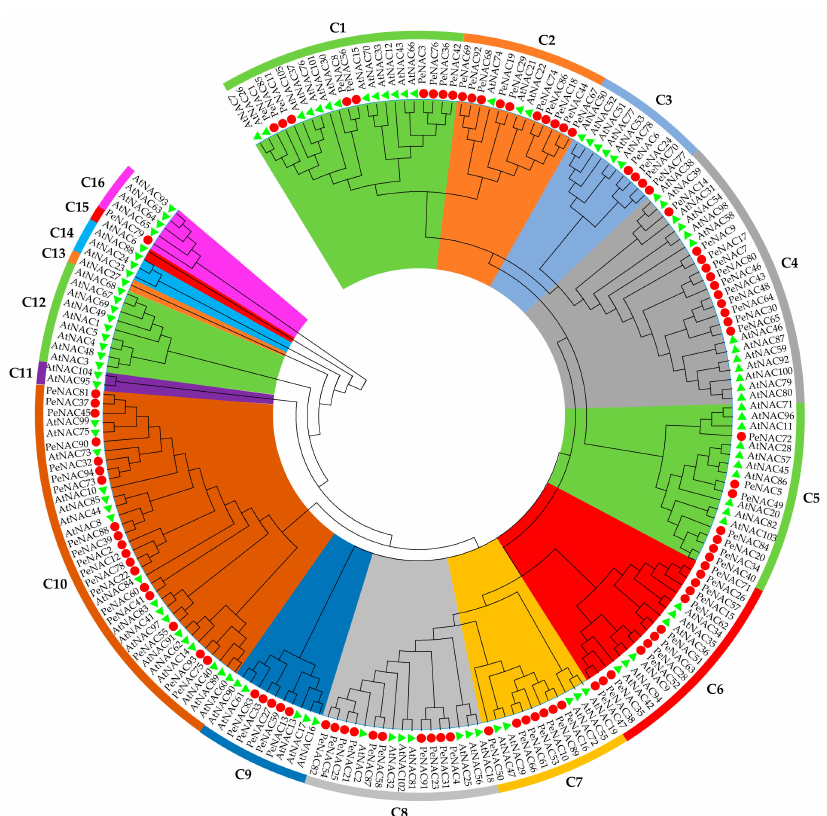
Figure 3. Phylogenetic tree based on the proteins of moso bamboo and Arabidopsis . The tree was constructed using the neighbor-joining (N–J) method with 1000 bootstrap replicates as implemented in MEGA6.0. The names of clade were shown outside of the circle. Geometric figures of di ff erent colors and shapes were used to mark the NAC members from di ff erent